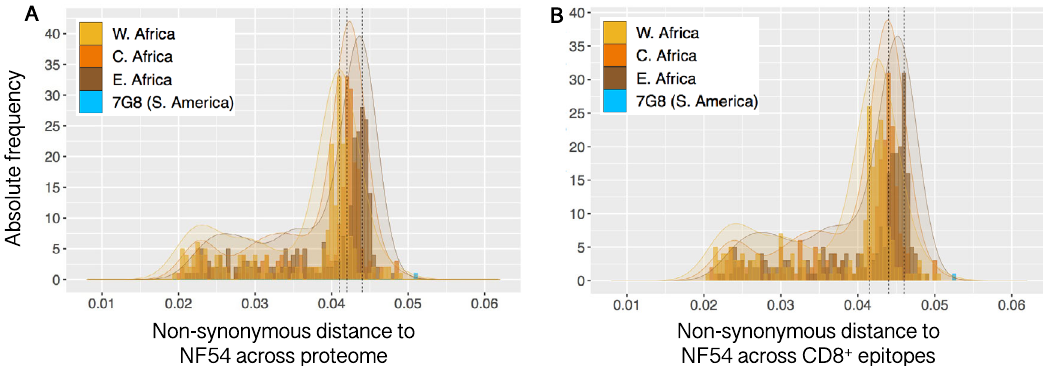
Fig. 3 Pairwise distance in non-synonymous sites of 704 Pf African isolates and of Pf7G8 to PfNF54. a Distance estimated across 54,853 variable, non- synonymous sites across the Pf proteome. b Distance estimated for 43,607 variable, non-synonymous sites that fall on predicted CD8 + T cell epitopes predicted to bind to one or more of the 26 HLA alleles analyzed. Legend as in Fig. 1. Again, the pairwise proteome difference between NF54 and the Brazilian clone Pf7G8 is larger than the distance of any African isolate to PfNF54, both across all variable non-synonymous sites (5.11%) and only in those that fall on predicted epitopes